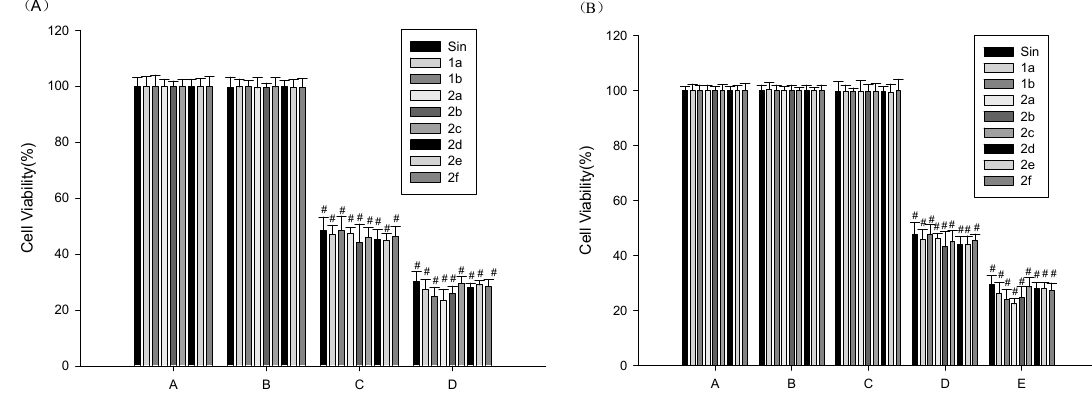
Figure 3. The effects of Sin, Sin derivatives and/or LPS on viability of peritoneal macrophages. ( A ) Cells were treated with Sin and Sin derivatives (final concentrations: A = Vehicle, B = 2 × 10 − 2 , C = 5 × 10 − 2 , D = 1 × 10 − 1 mg/mL) for 24 h; ( B ) Cells were treated with Sin and Sin derivatives (final concentrations: A = Vehicle, B = Vehicle + LPS, C = 2 × 10 − 2 , D = 5 × 10 − 2 , E = 1 × 10 − 1 mg/mL and LPS (final concentrations = 10 µg/mL) for 24 h. The results were expressed as mean ± SEM. The results were analyzed by a one-way ANOVA followed by the LSD test ( # p < 0.001 vs. Vehicle ( A ) or the LPS- treated group ( B )).